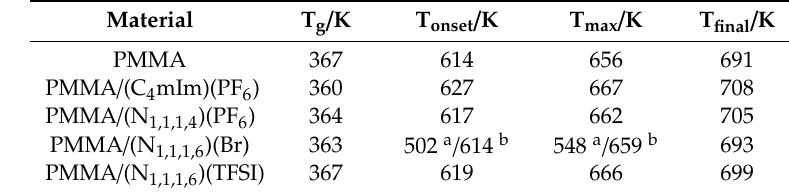
Table 2. E ff ect of imidazolium- or ammonium-based ILs on the Tg (DSC) and thermal stability—T onset , T max , and T final corresponding to the starting, maximum, and end of degradation—considering the first derivative of the weight loss vs. temperature, respectively. Material T g / K T onset / K T max / K T final / K PMMA